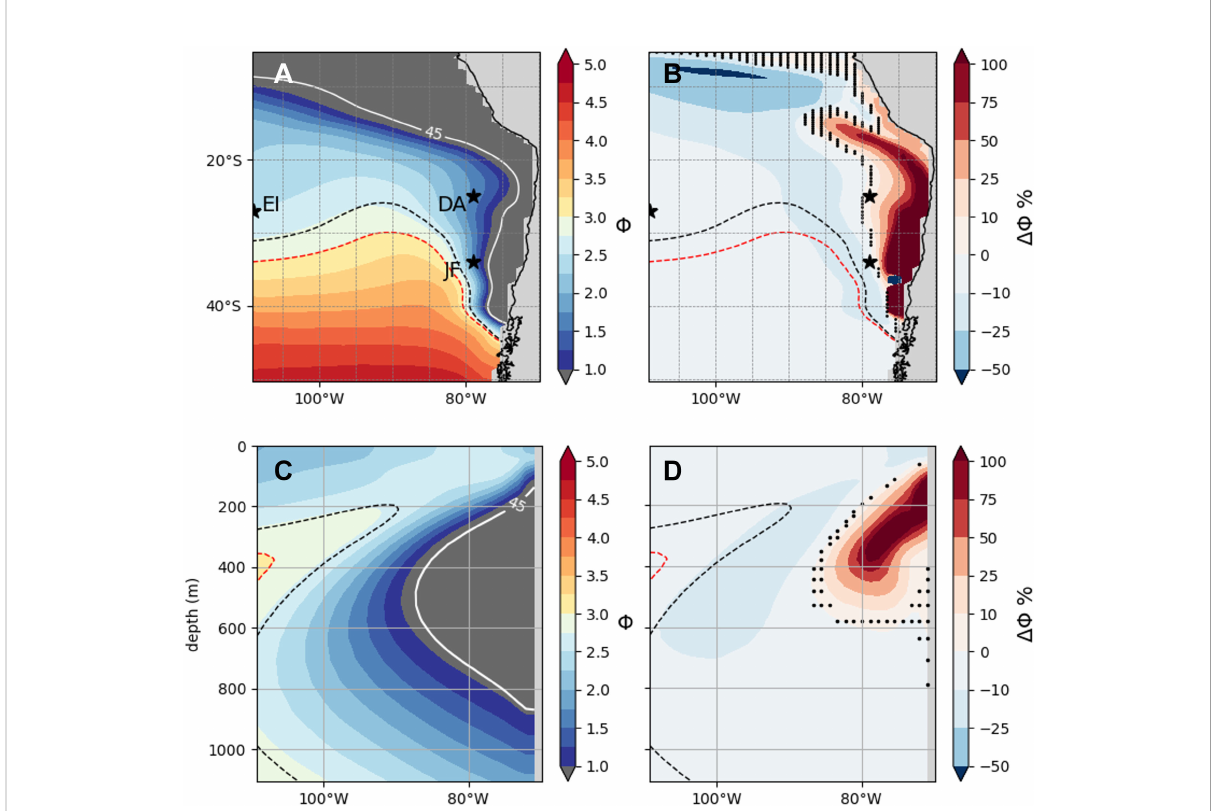
FIGURE 2 Metabolic index of the model species ( Ф model ). Mean metabolic Index (A, C) and change ( DF ) between the present and future climate (B, D) at 200m (A, B) and 26°S (C, D) .The dashed isocontours indicate the position of the mean F crit (=3) in the present (black) and the future (red) climates. The white line is the mean 45 mmol.m -3 oxygen isocontour of the future climate. The dark grey shading is where F < 1. The dark stars represent Juan Fernandez (JFA), the Desventuradas Archipelagos (DA) and Easter Island (EI). The black dots (B, D) indicate where DF is not signi fi cant across the 34 members (Wilcoxon rank sum test p <